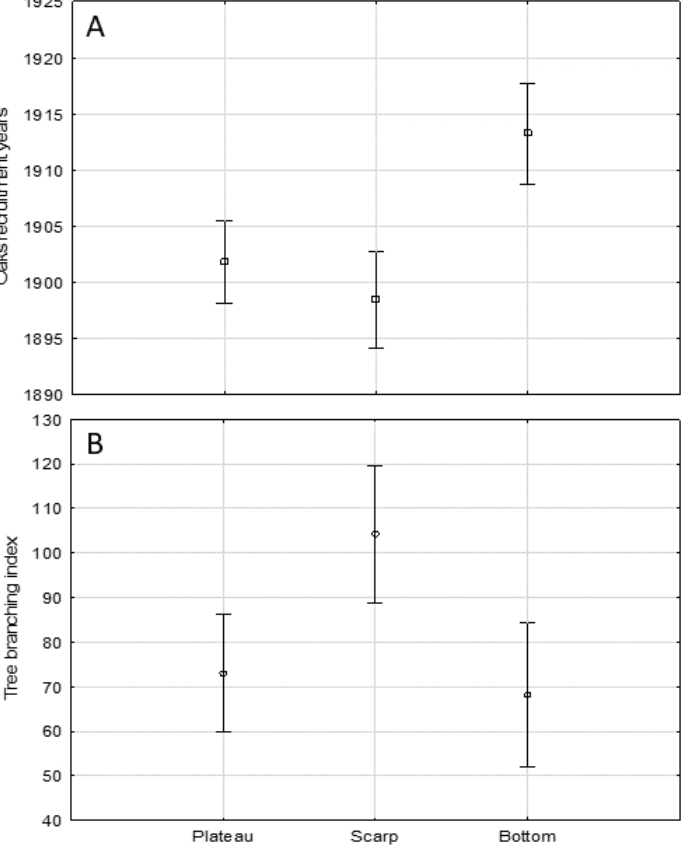
Figure 6. Exponentially decreasing oaks’ tree branching index based on the data from 46 cored oaks; r = − 0.702.